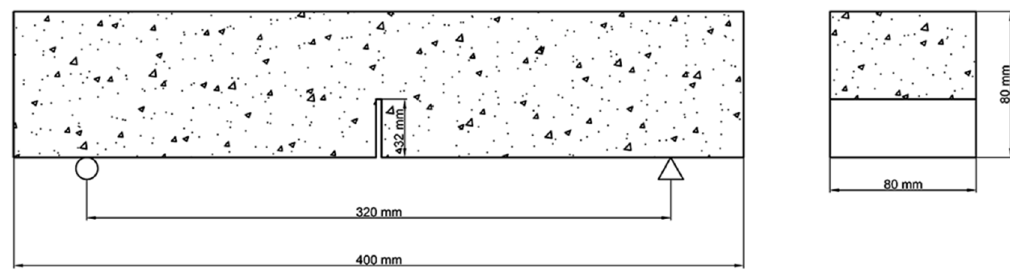
Figure 2. Schematic diagram of the three-point bending test.